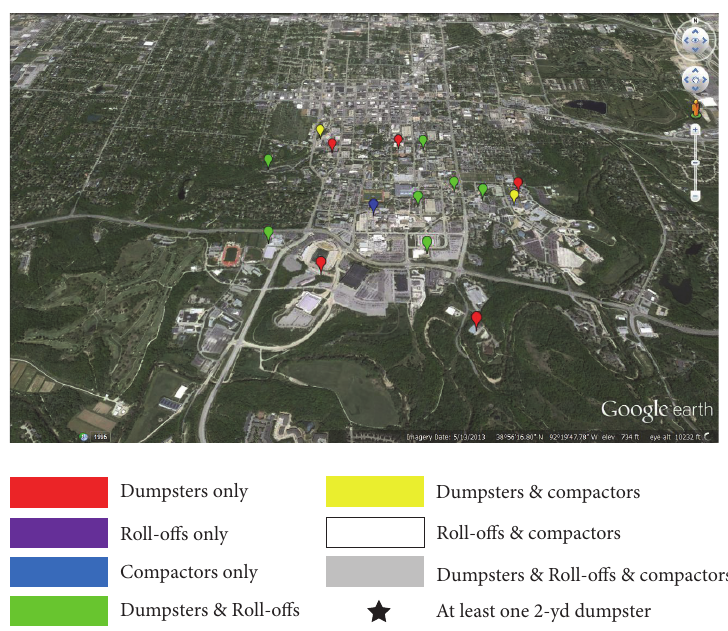
Figure 4: Distribution of receptacles around MU campus, nonrobust ( 𝜂 = 0 ) solution.